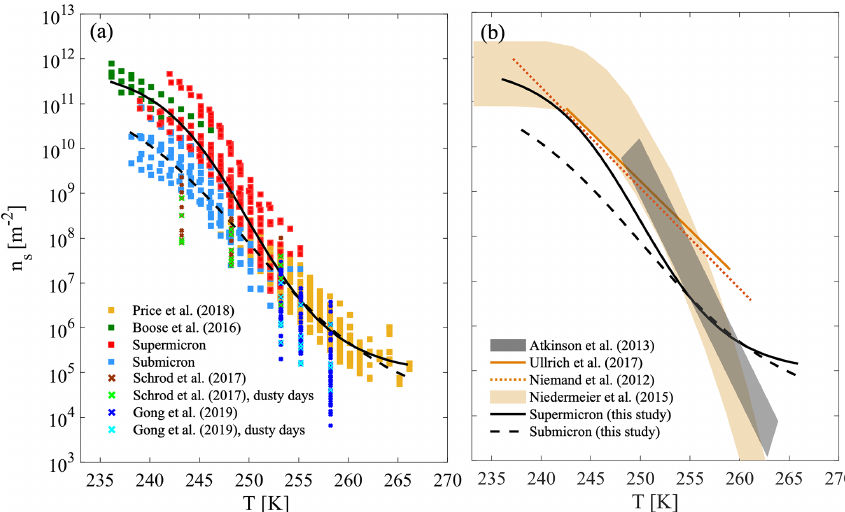
Figure 9. Heterogeneous ice nucleation by airborne particles during dusty conditions. (a) Active site densities of supermicron and submicron size classes from this study are shown together with flight data (Schrod et al., 2017, and Price et al., 2018) and deposited or in situ data (Boose et al., 2016b, and Gong et al., 2019). New parameterizations, which were derived in this work based on the combined AMD data of the different studies, are shown for supermicron and submicron classes. (b) The new parameterizations derived in this study based on all AMD data are shown next to recent parameterizations for desert dust (Ullrich et al., 2017, and Niemand et al., 2012) and K feldspar predictions (Atkinson et al., 2013 and Niedermeier et al.,